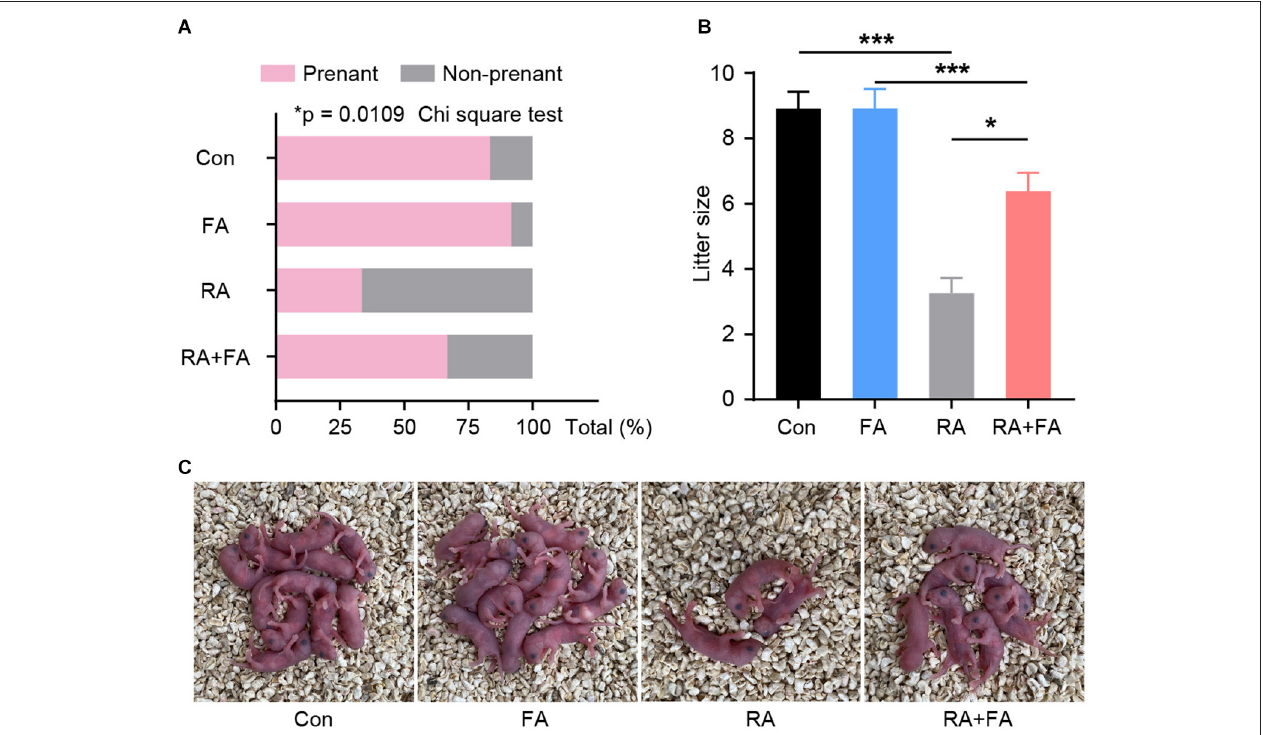
FIGURE 6 | Effect of folic acid (FA) pre-administration on reproductive performance after radiation injury. (A) Quantitative analysis of the pregnancy rate in each group. N = 12, * p < 0.05, Chi square tes. (B) Quantitative analysis of the average litter sizes produced by the female mice of each group. * p < 0.05 and *** p < 0.001. (C) Representative pictures of the litter at birth for each group. Con, control group; FA, FA pre-administration control group; RA, radiation exposure group; RA + FA, FA pretreatment + radiation exposure group. Error bars, standard error of mean